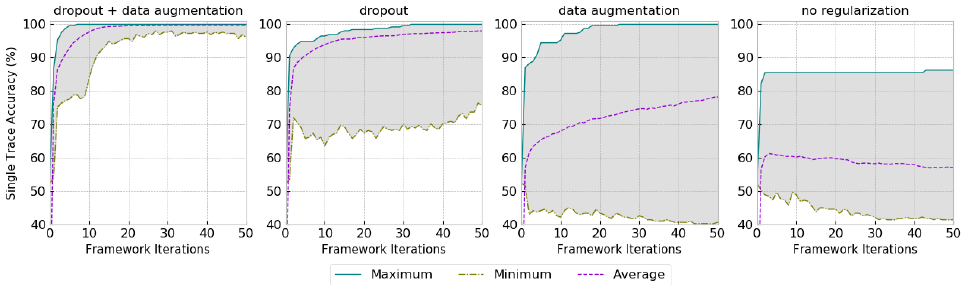
Figure 13: Fixed CNN hyperparameters: minimum, maximum, and average single trace accuracy with iterative framework on the cswap-arith dataset and attacking the sample interval range from 1 500 to 3 500 of all sub-traces.